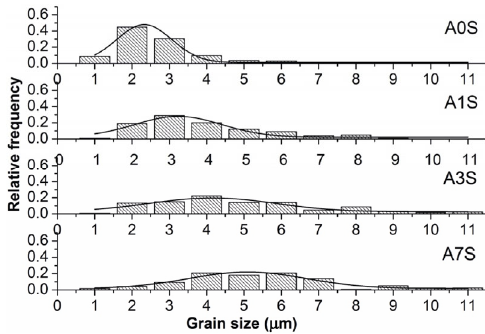
Fig. 3 Grain size distributions of the samples A0S, A1S, A3S, and